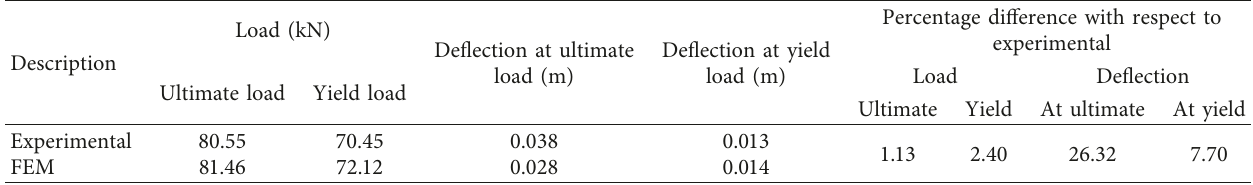
Table 4: Summary of numerical and experimental load-deflection results for control specimen.